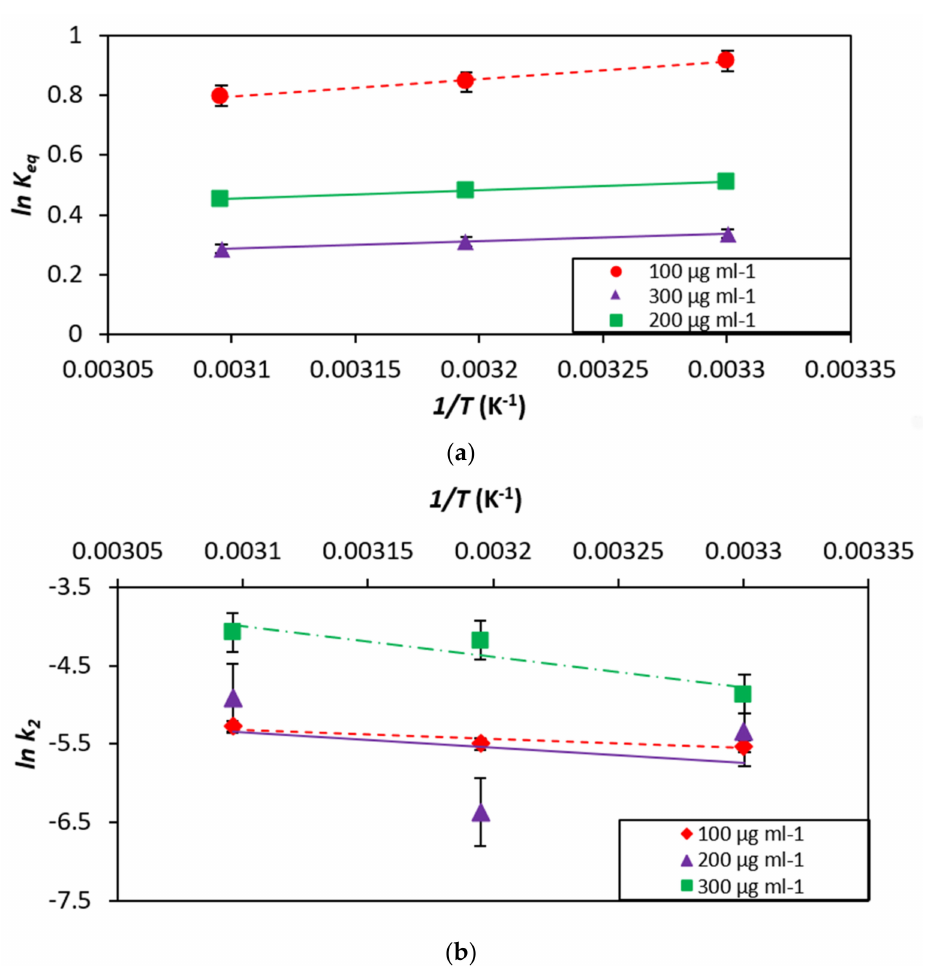
Figure 12. ( a ) Determination of enthalpy and Gibbs free energy: plot of thermodynamic equilibrium constant against 1/T and ( b ) Determination of activation energy: plot of pseudo-second order kinetic constant against